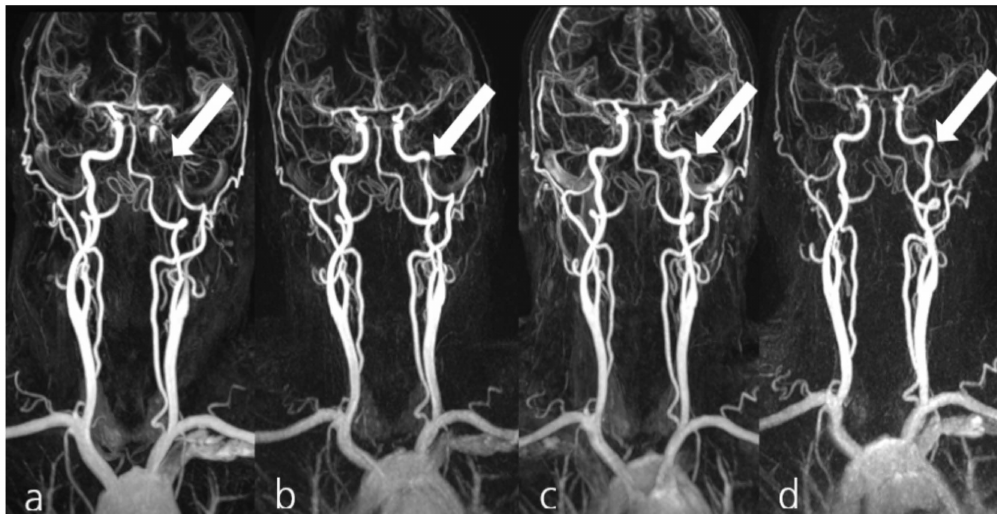
Figure 3. Exemplary display of patient #1 from group II, presenting with a spontaneous dissection of the left internal carotid artery ( a , arrow). MRA confirmed the collateral supply for the occluded artery from the right-hand anterior circulation ( a ). The patient received 2 × 150 mg dabigatran, 1 × 100 mg ASA and 2 × 90 mg ticagrelor PO daily. Follow-up MRA examinations 16 days ( b ), 29 days ( c ), and 141 days ( d ) demonstrated the progressive recanalization of the dissected artery